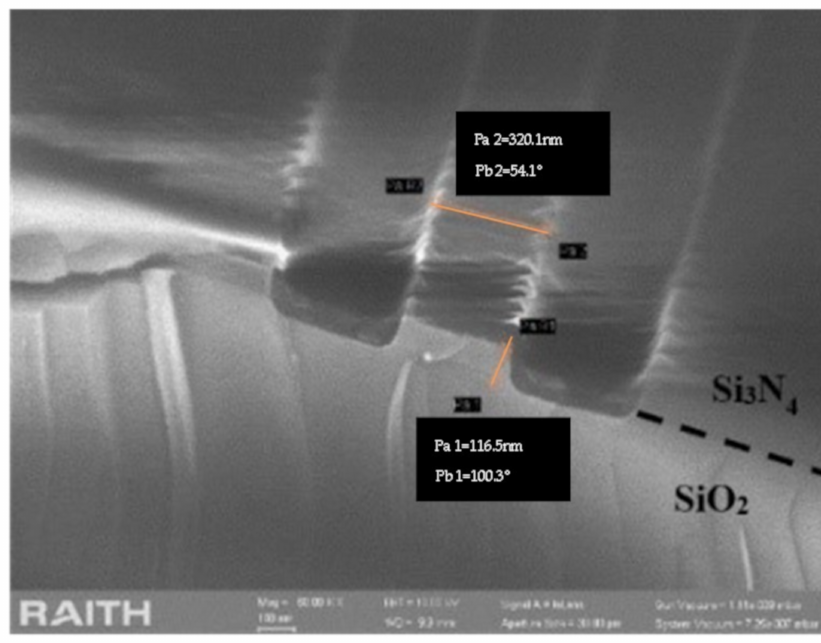
Figure 19. Etching result after RIE with the protection of PMMA-A4.